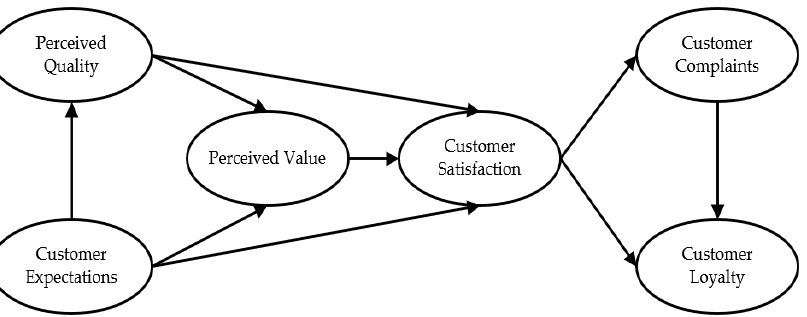
Figure 1. American Customer Satisfaction Index model.